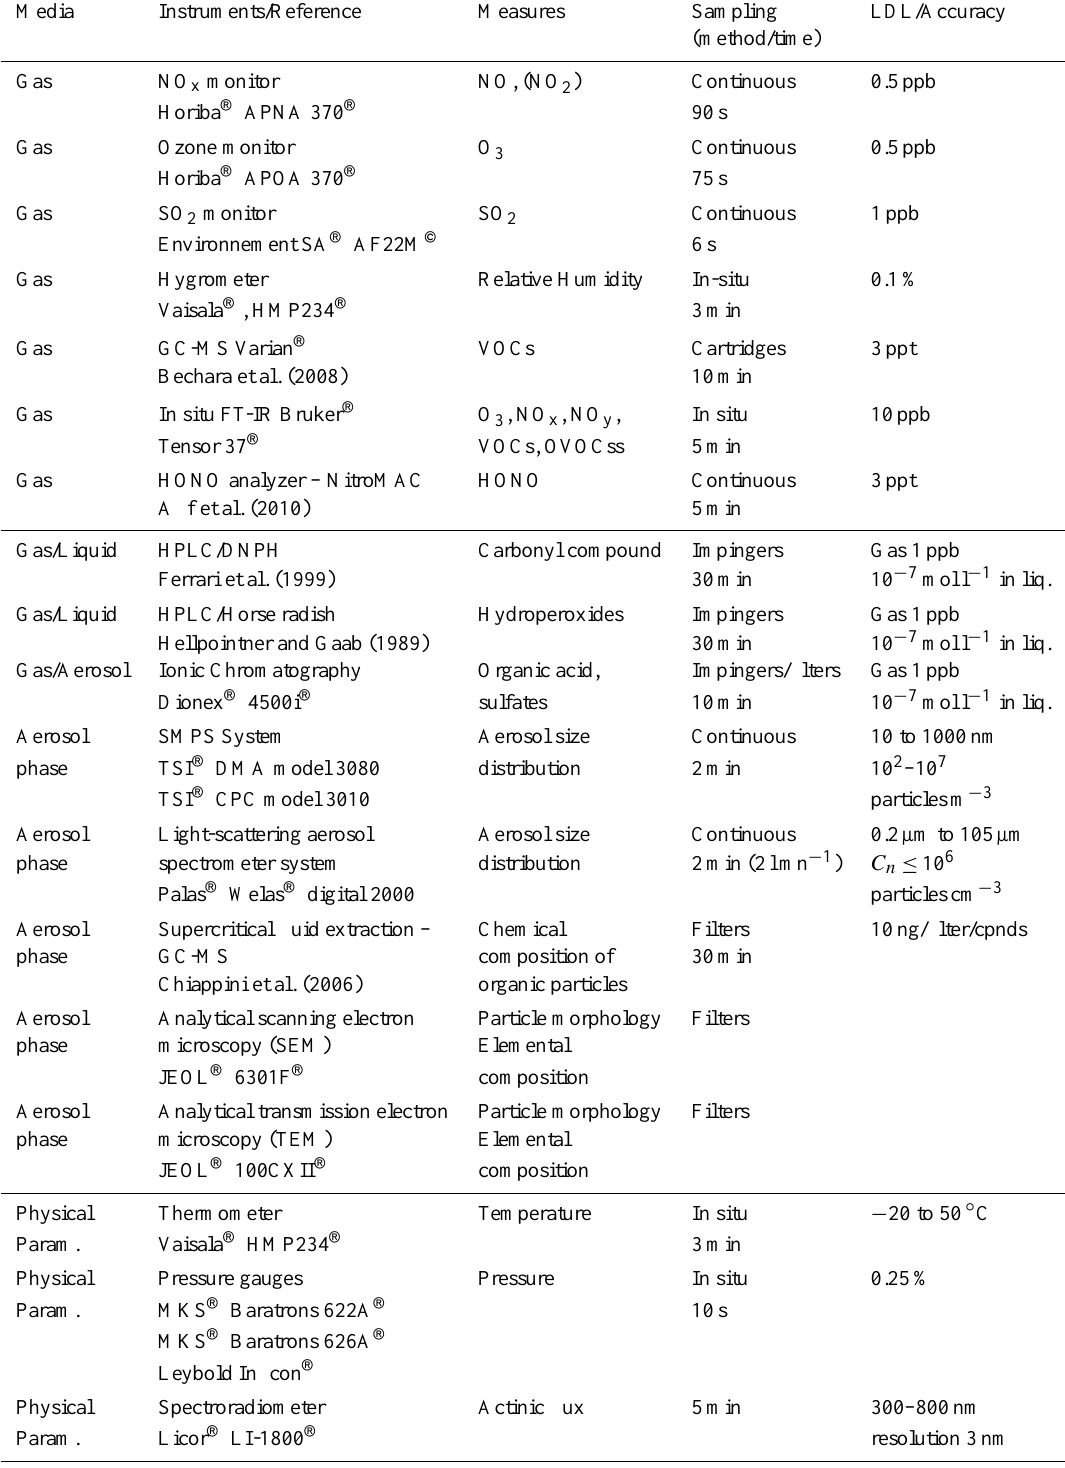
Table 1. Instrumentation summary: the sampling time and the detection limit depending on the measured species and/or instrumental parameters and are given for references